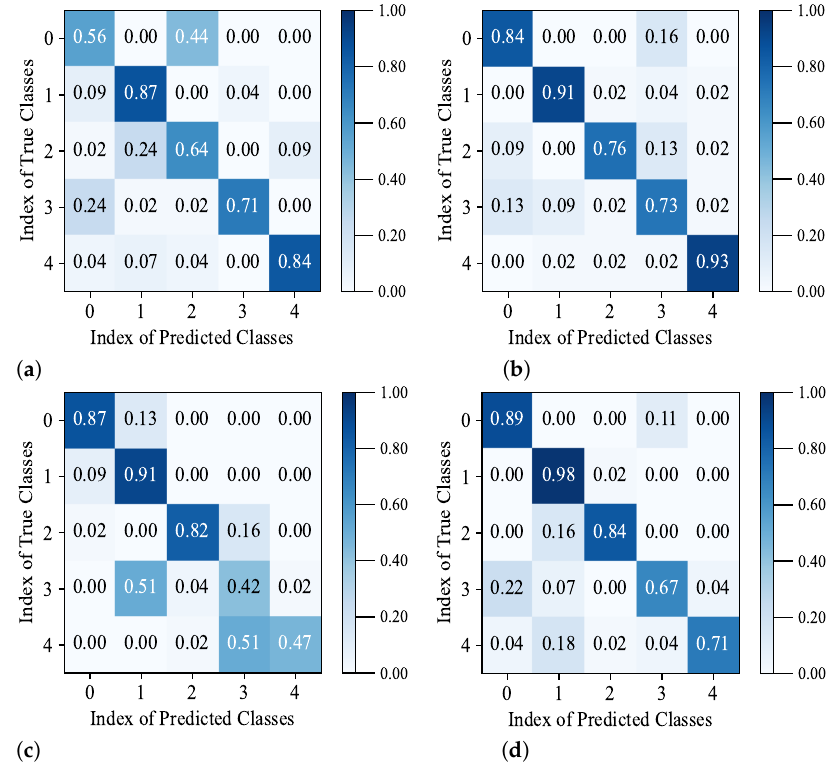
Figure 5. Confusion matrices of our proposed model with different conditions on two datasets. ( a ) the confusion matrix on the NWPU-RESISC45 of 5-way 1-shot case, ( b ) the confusion matrix on the NWPU-RESISC45 of 5-way 5-shot case, ( c ) the confusion matrix on the WHU-RS19 of 5-way 1-shot case, and ( d ) the confusion matrix on the WHU-RS19 of 5-way 5-shot